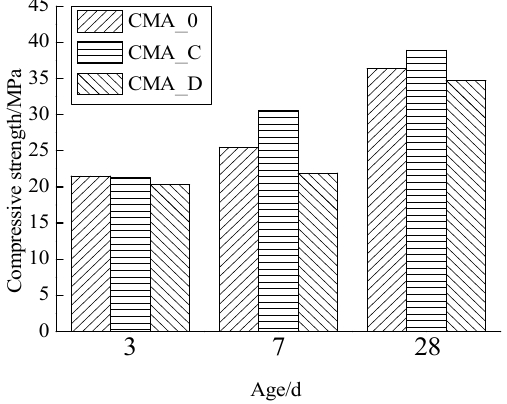
Figure 4. Compressive strength of concrete.